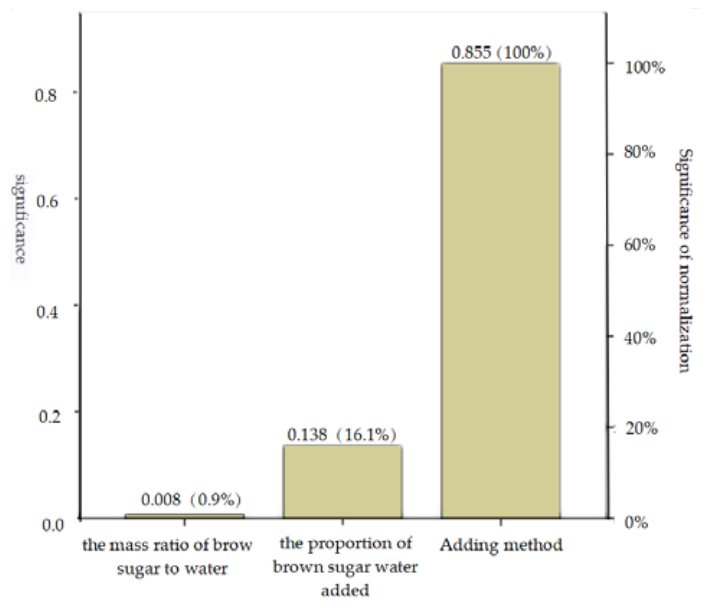
Polymers 2020 , 12 , x FOR PEER REVIEW